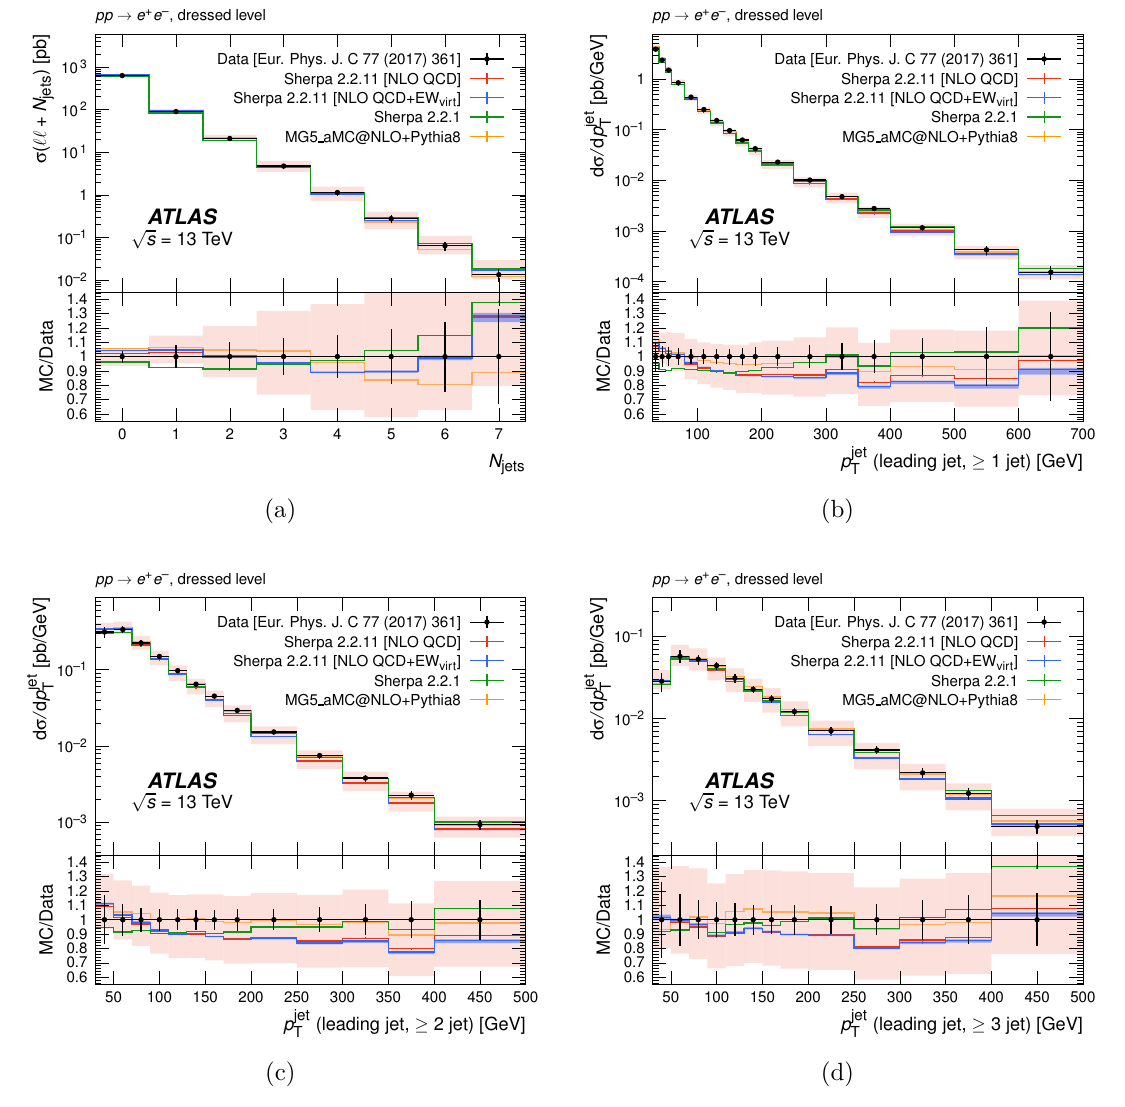
Figure 6 . Comparisons between generator-level Z → ee predictions and measured data points. The red uncertainty band includes the envelope of the 7-point scale variations around the Sherpa 2 . 2 . 11 NLO QCD prediction. The blue uncertainty band is the envelope of multiplicative and exponen- tiated NLO EW schemes around the additive NLO EW prediction. Data points are taken virt virt √ from ATLAS measurements at s = 13 TeV